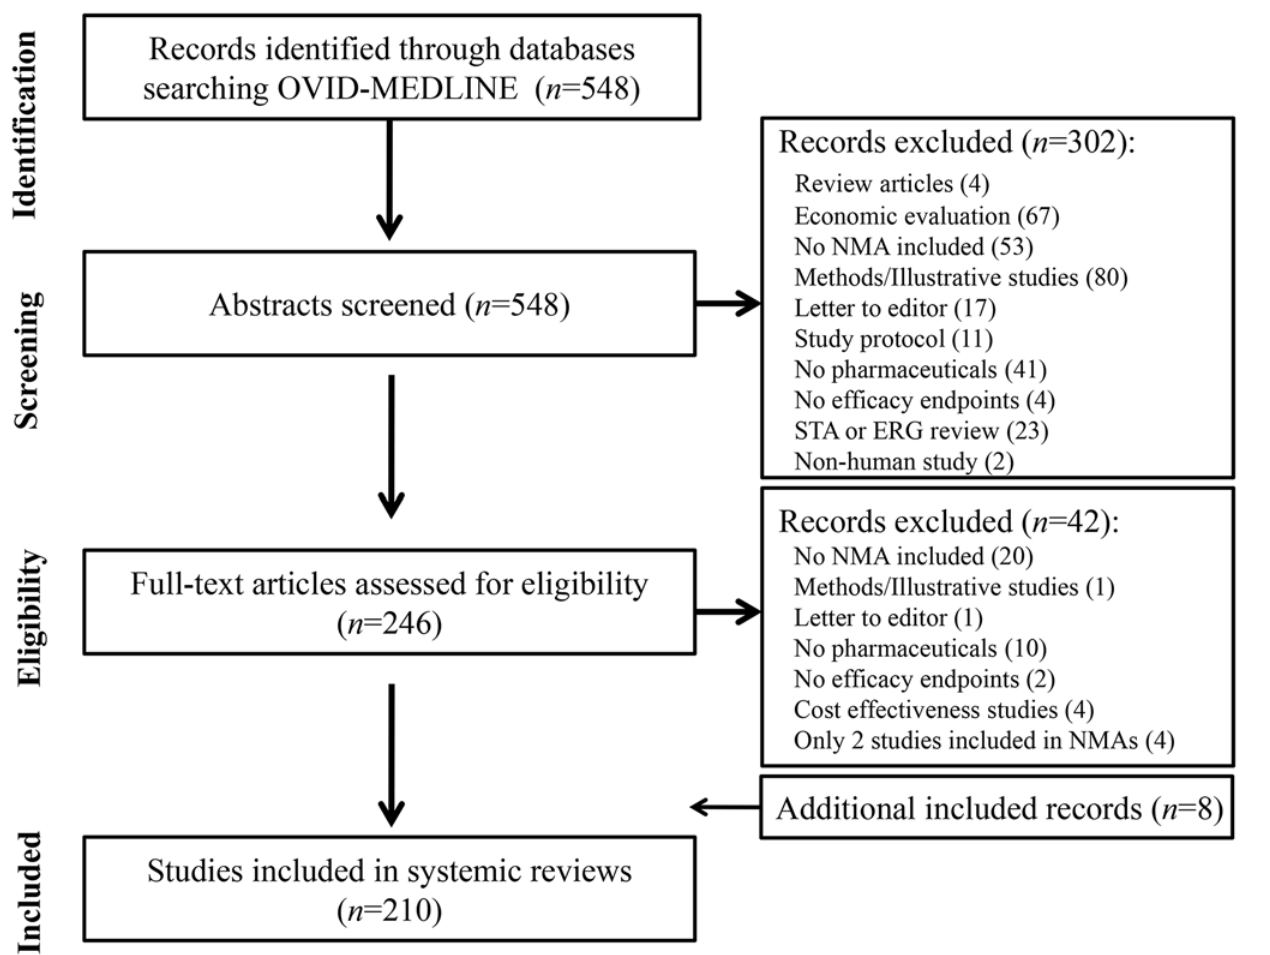
Fig 1. Identification of network meta-analyses included in